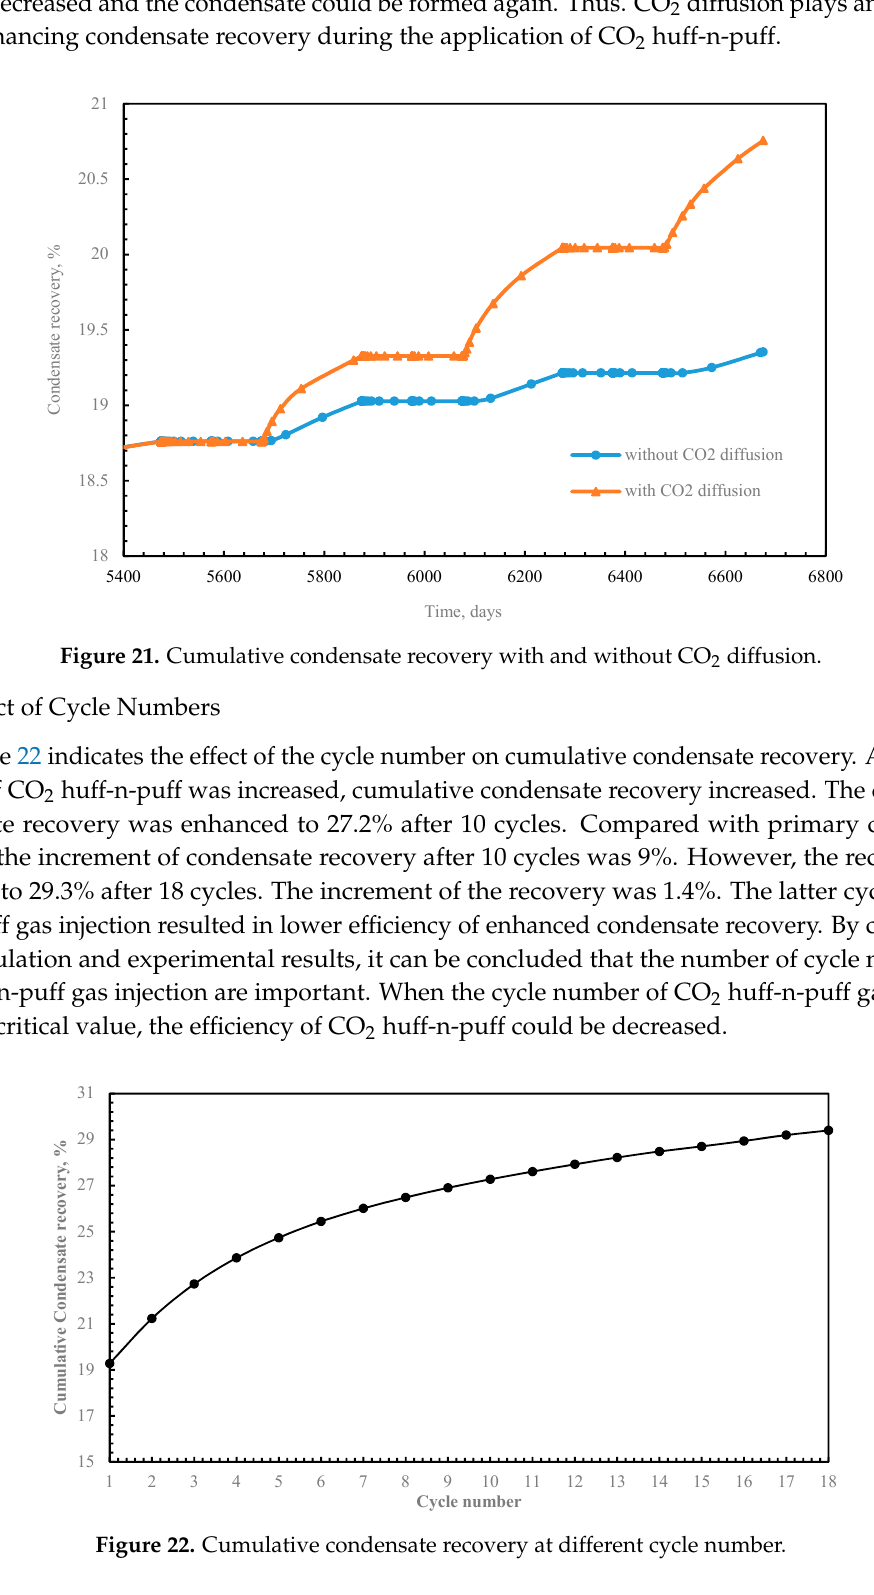
( b ) Figure 20. Pressure distribution near the fracture, injection pressure: 5000 psi; ( a ) start of soaking time; ( b ) end of soaking time. It can be concluded that whether a soaking process should be applied or not depends on the injection pressure. When the injection pressure is similar as the dew point pressure, a soaking process could have a negative effect on the efficiency of CO 2 huff-n-puff. However, when the injection pressure is much higher, a soaking process is recommended. The determination of soaking time depends on the area of the condensate region. In general, during the soaking process, the pressure of the main condensate region should be remained higher than the dew point pressure again, otherwise